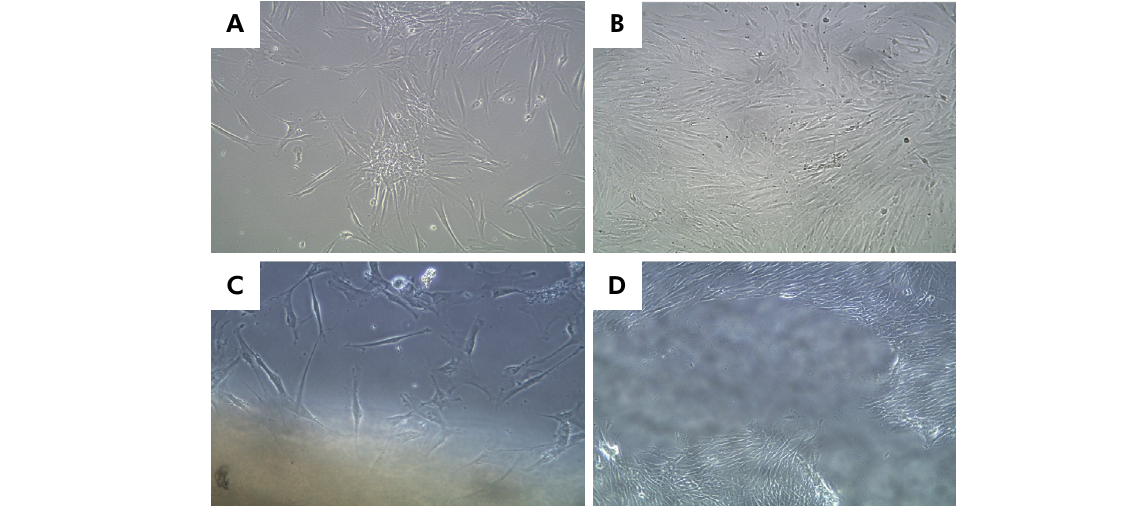
Figure 4. Aspect of pulp cells for enzymatic digestion (ED) technique (A and B) and Explant (EX) technique (C and D). (A) – 6 days after tissue obtaining, (B) –15 days of tissue obtaining, (C) – 6 days after tissue obtaining, (D) - 15 days of tissue obtaining. 29-year-old donor. A, B and D – X10, C- X40.